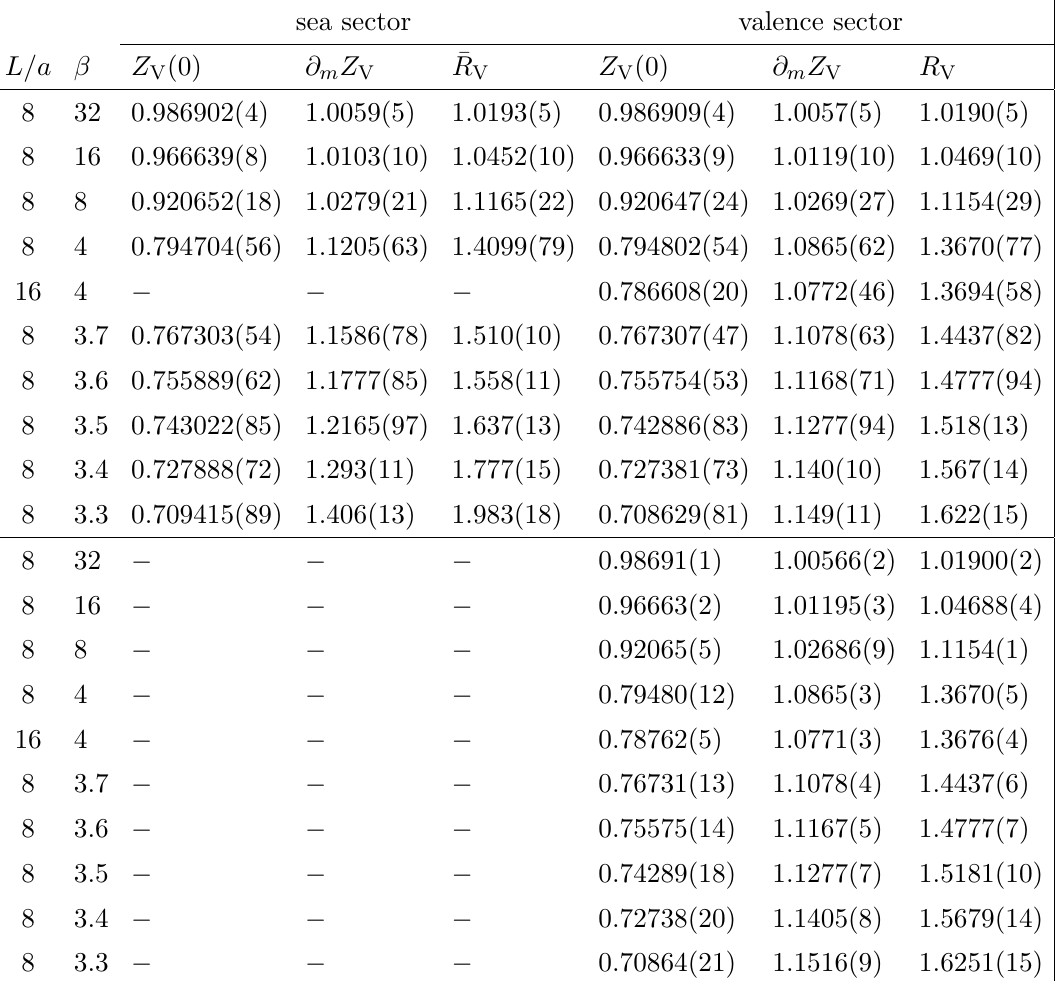
Table 3. Summary of results and data analysis for (cid:22) R am q < 0 : 014. Note that the simulation of L=a = 16 at (cid:12) = 4 : 0 has (cid:20) = 0 : 13668396 and j j Lm = 0 : 0006(8), cf. table 10 of ref. [26]. (top rows: uncorrelated analysis, bottom rows: fully correlated